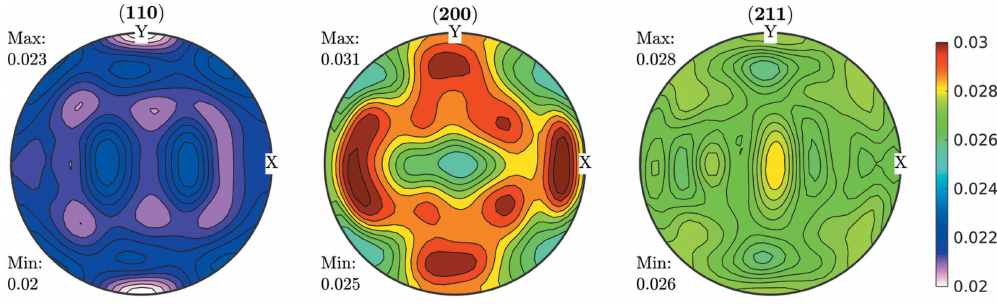
Figure 5 Recalculated GPFs by removal of 30% of the FWHM values corresponding to the peaks with the lowest intensities ( (cid:6) ) for the cold-rolled sample. The stability of the GPF reconstruction was also used as criteria for studying the compatibility of the GPFs. Comparison with the results from Fig. 4 shows that the GPF reconstruction is not greatly affected by removing the data obtained from the peaks with the lowest intensities.